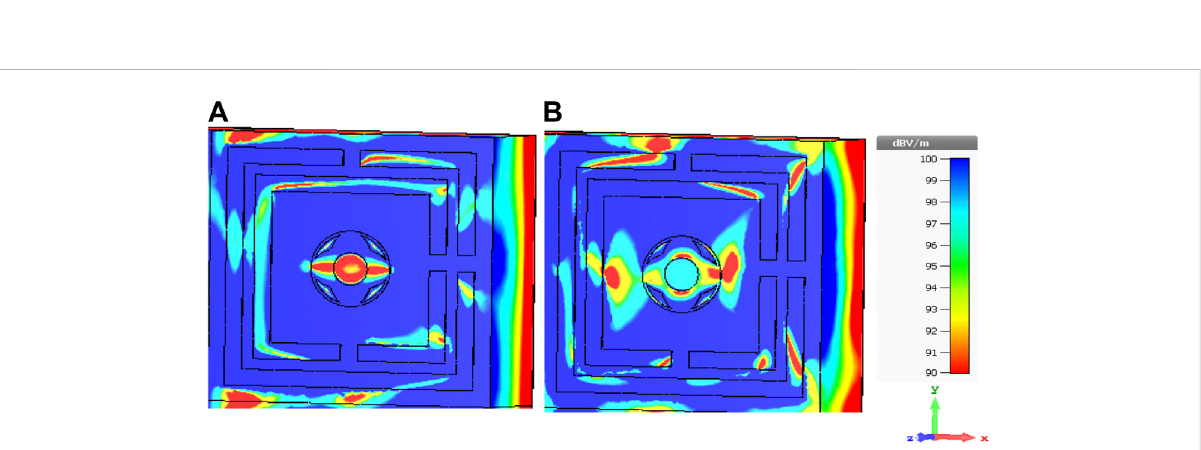
FIGURE 21 Simulated electric fi eld distribution for the MTM unit cell at (A) 0.88 THz and (B) 1.42 THz.